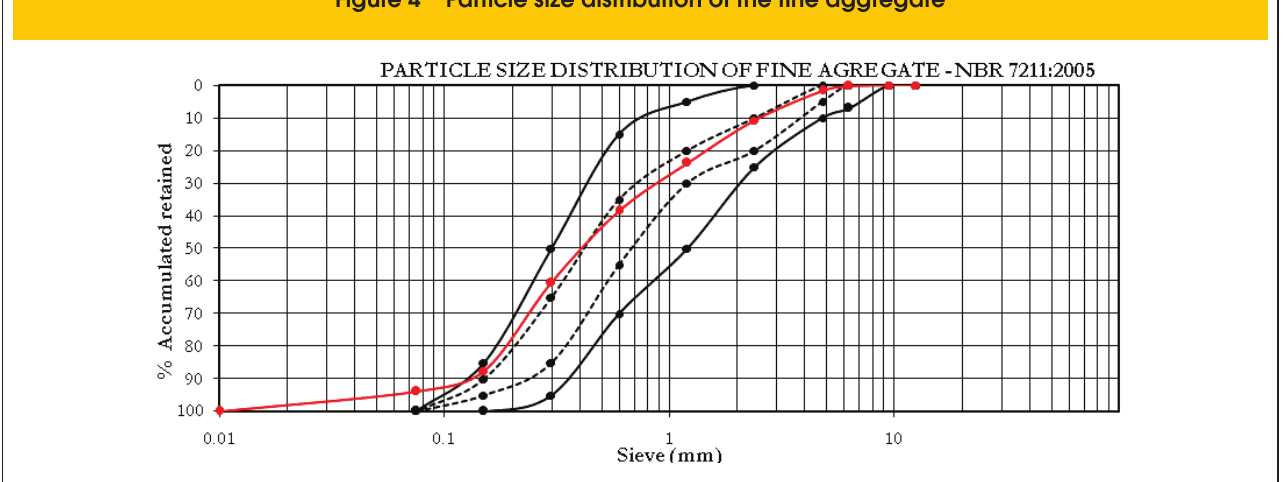
Figure 4 – Particle size distribution of the fine aggregate